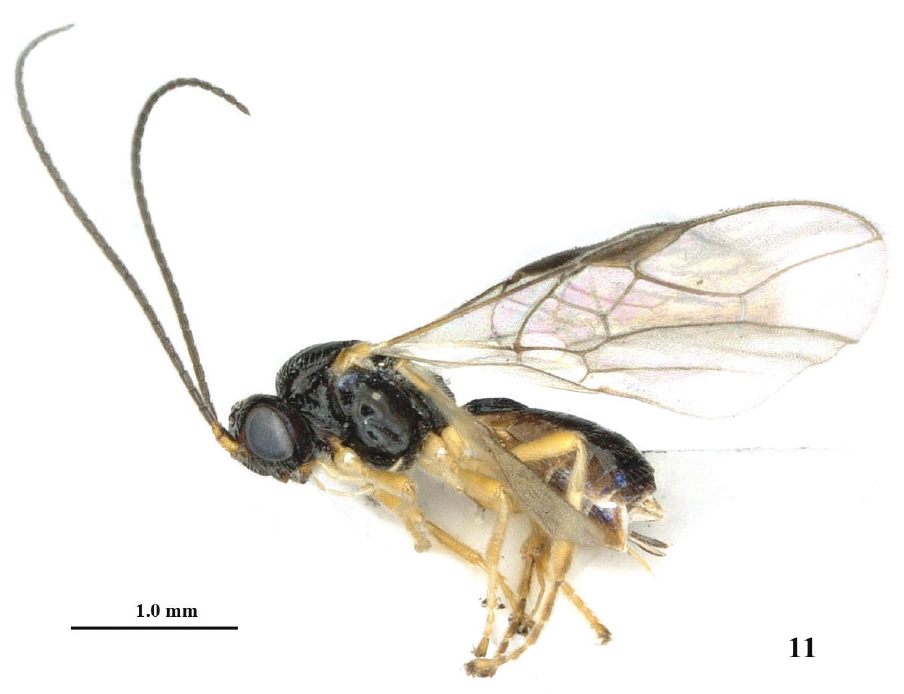
Figure 11. Rhogadopsis cracentata sp. n., female, holotype, habitus lateral. wide (about 3 times in R. moniliata ), the propodeum with some superficial rugae (with complete median carina and costulae), the precoxal sulcus short (long) and the hind femur 3 times as long as wide (about 4.5 times). The length of the ovipositor sheath of R. infernalis is unknown because the type series consists of only